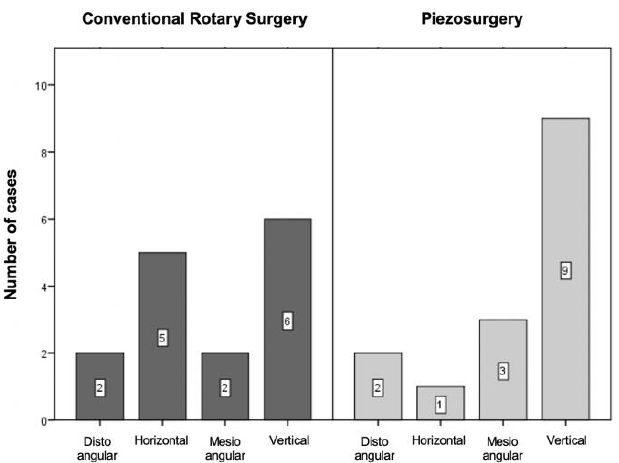
Figure 4. Sample distribution according to the modified version of the Parant scale ( p = 0.136 for the comparison between the two techniques).